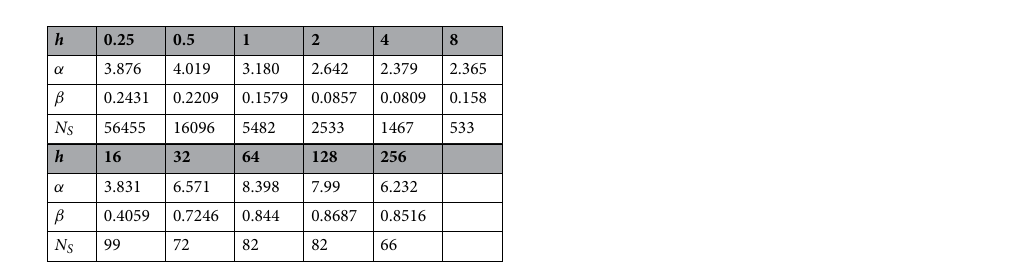
Table 3. Parameters of least-squares fitting, according to Eq. (3), for different contagion radii h and for a population P = 1001 .